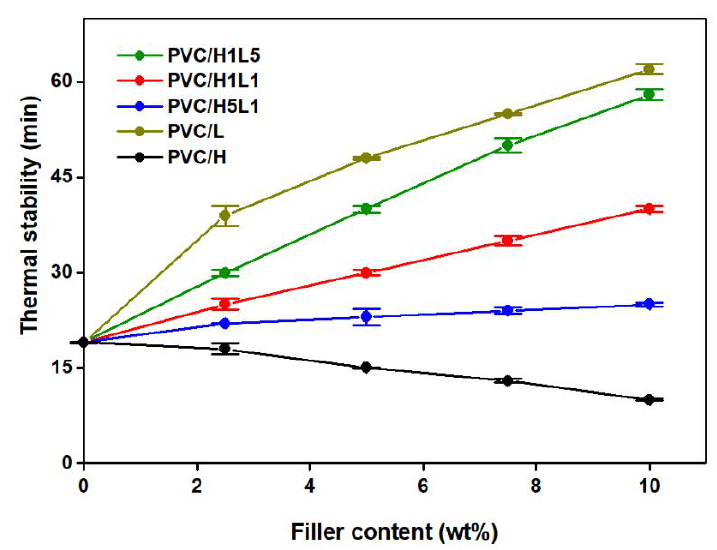
Figure 6. Thermal stability of PVC and PVC-based composites vs. filler content: lignin, halloysite and halloysite – lignin hybrid materials.